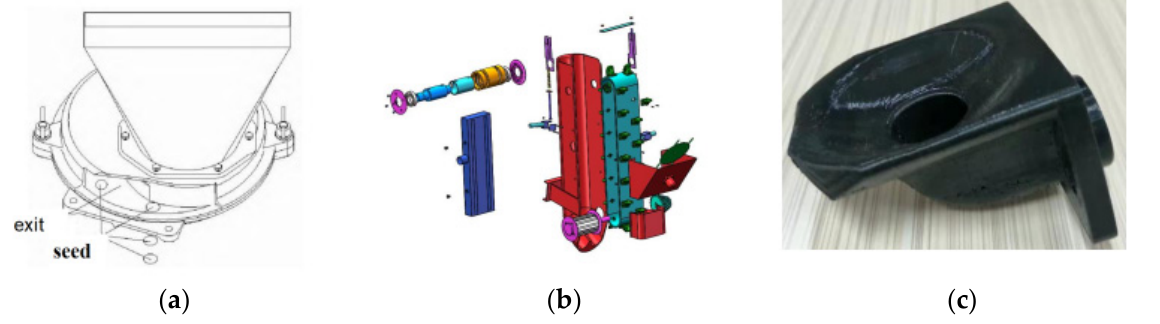
Figure 10. Improved pneumatic-type seed metering device. ( a ) Mao et al.’s research. Reprinted with permission from ref. [55]. Copyright 2013 Huazhong Agricultural University; ( b ) Liu et al.’s research. Reprinted with permission from ref. [49].; ( c ) Improved seed scoop. Reprinted with permission from ref. [49] Copyright 2019 Shandong Agricultural University.